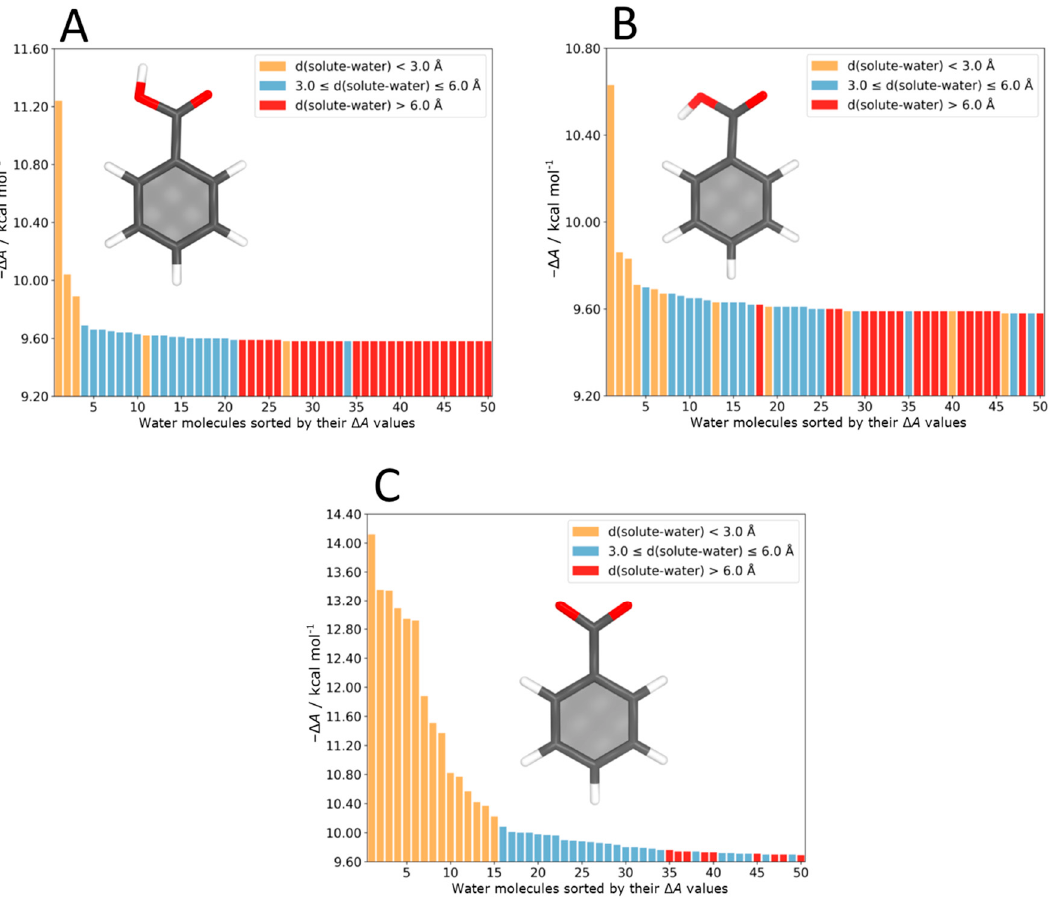
Figure 9. Bar chart of the FEBISS calculation for syn -BA ( A ) and anti- BA ( B ) as well as of benzoate ( C ).